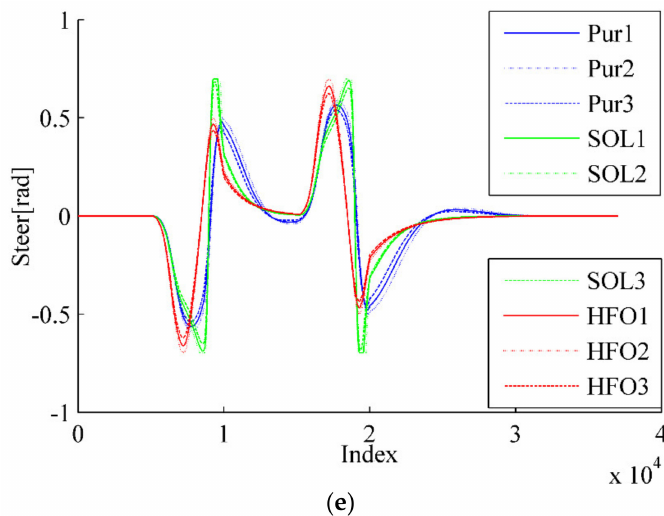
Figure 5. Double lane-changing test scenario. ( a ) Trajectory tracking (3D), ( b ) Trajectory tracking (2D), ( c ) Lateral error, ( d ) Heading angle, ( e ) Steer angle.